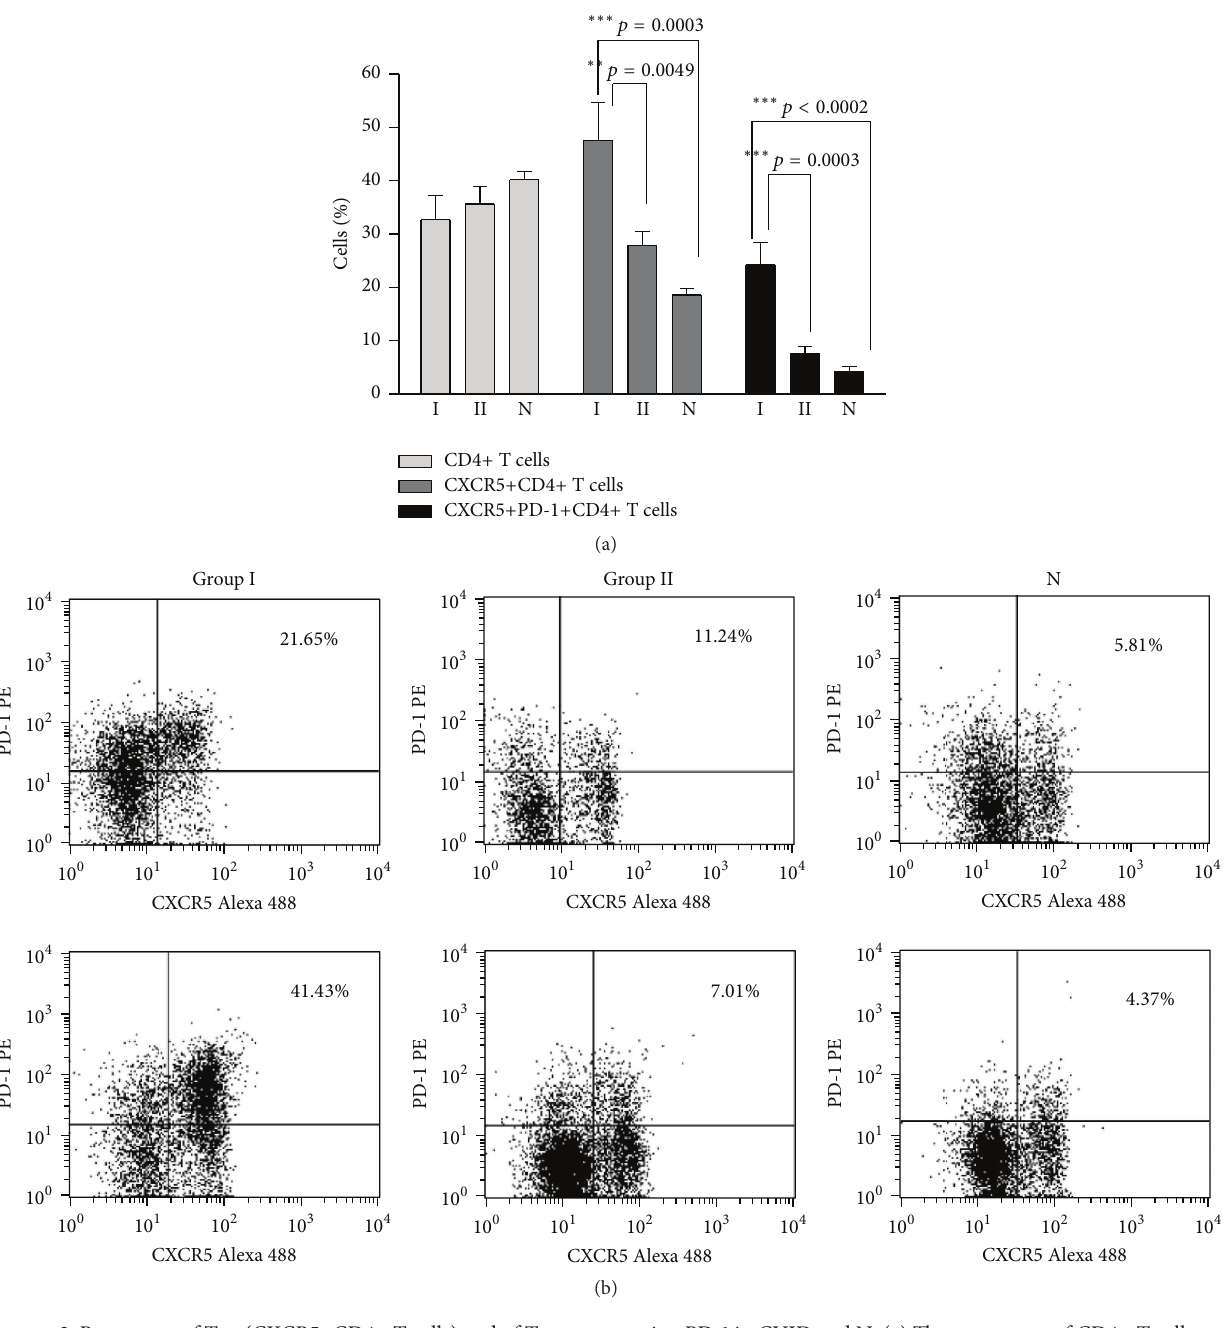
Figure 2: Percentage of T FH (CXCR5+CD4+ T cells) and of T FH coexpressing PD-1 in CVID and N. (a) The percentage of CD4+ T cells and CD4+ T coexpressing CXCR5 or CXCR5+PD-1+ was assayed for CVID patient Groups I ( 𝑛 = 7 ) and II ( 𝑛 = 10 ) and N ( 𝑛 = 12 ). Statistical differences are consigned in the graph. (b) An example of cytometry analysis of two different Group I and Group II CVID patients and two different N